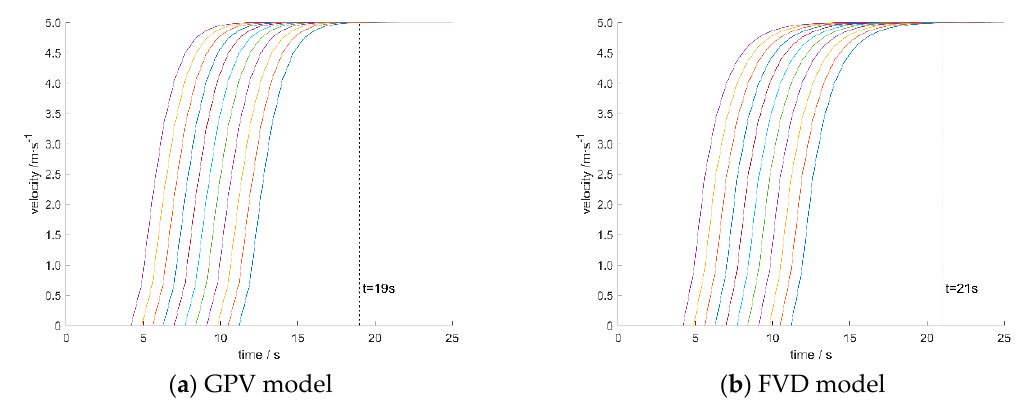
Figure 6. Comparison of velocity during the starting process between the two models.